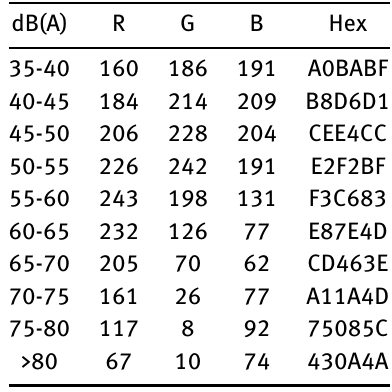
Table 3: Noise level color scheme for the I-PNS map reported in RGB